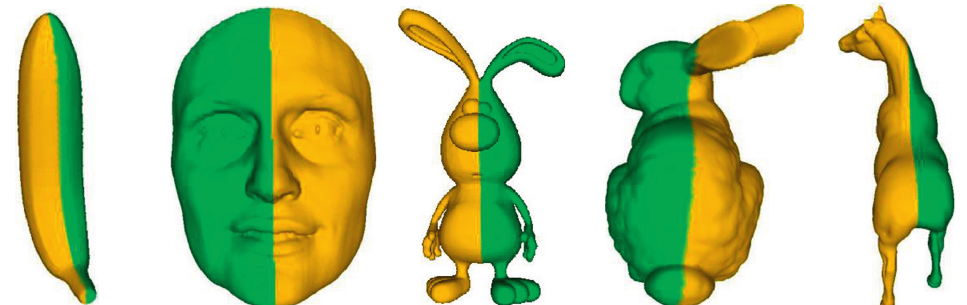
Figure 7: Experimental results for different point-based